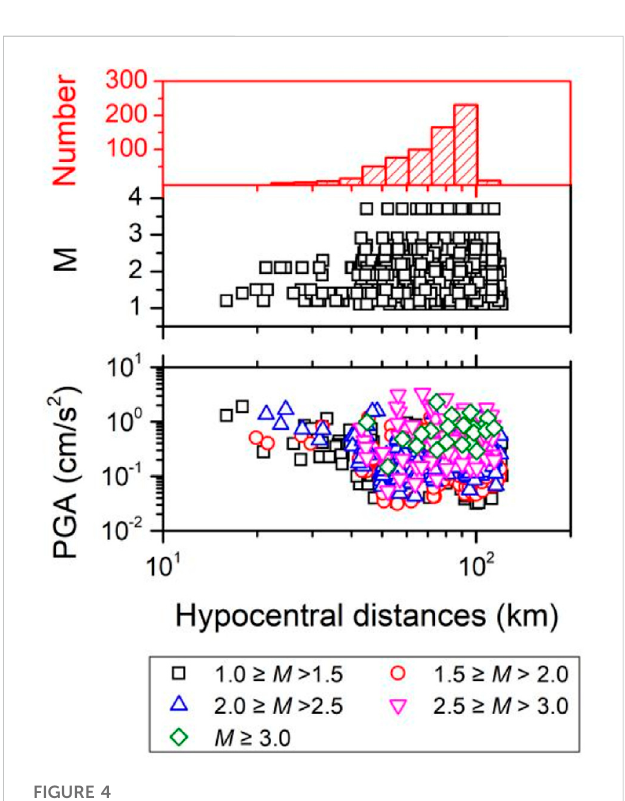
FIGURE 4 Distribution of magnitude and PGA vs. Hypocentral distances of recordings used for inversion. The red histogram is the cumulative distribution of Hypocentral